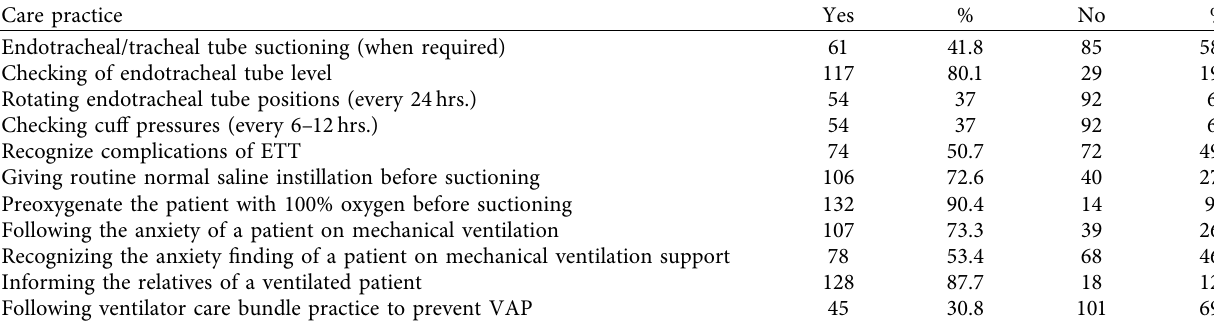
Figure 2: Level of practice regarding mechanical ventilator care among nurses working in the ICU of selected government hospitals in Addis Ababa, Ethiopia 2021 ( N � 146). Table 3: Practice nurses working in ICU regarding ventilatory care at selected government hospitals in Addis Ababa, Ethiopia 2021 ( N �